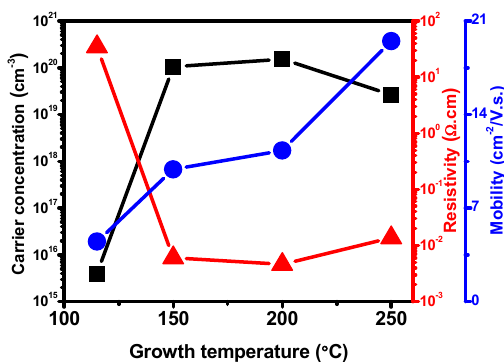
Figure 7. The variations in carrier concentration ( ■ ), resistivity ( ▲ ), and Hall mobility ( ● ) of the In 2 O 3 films deposited on a glass substrate as a function of the growth temperatures (115 °C, 150 °C, 200 °C, and 250